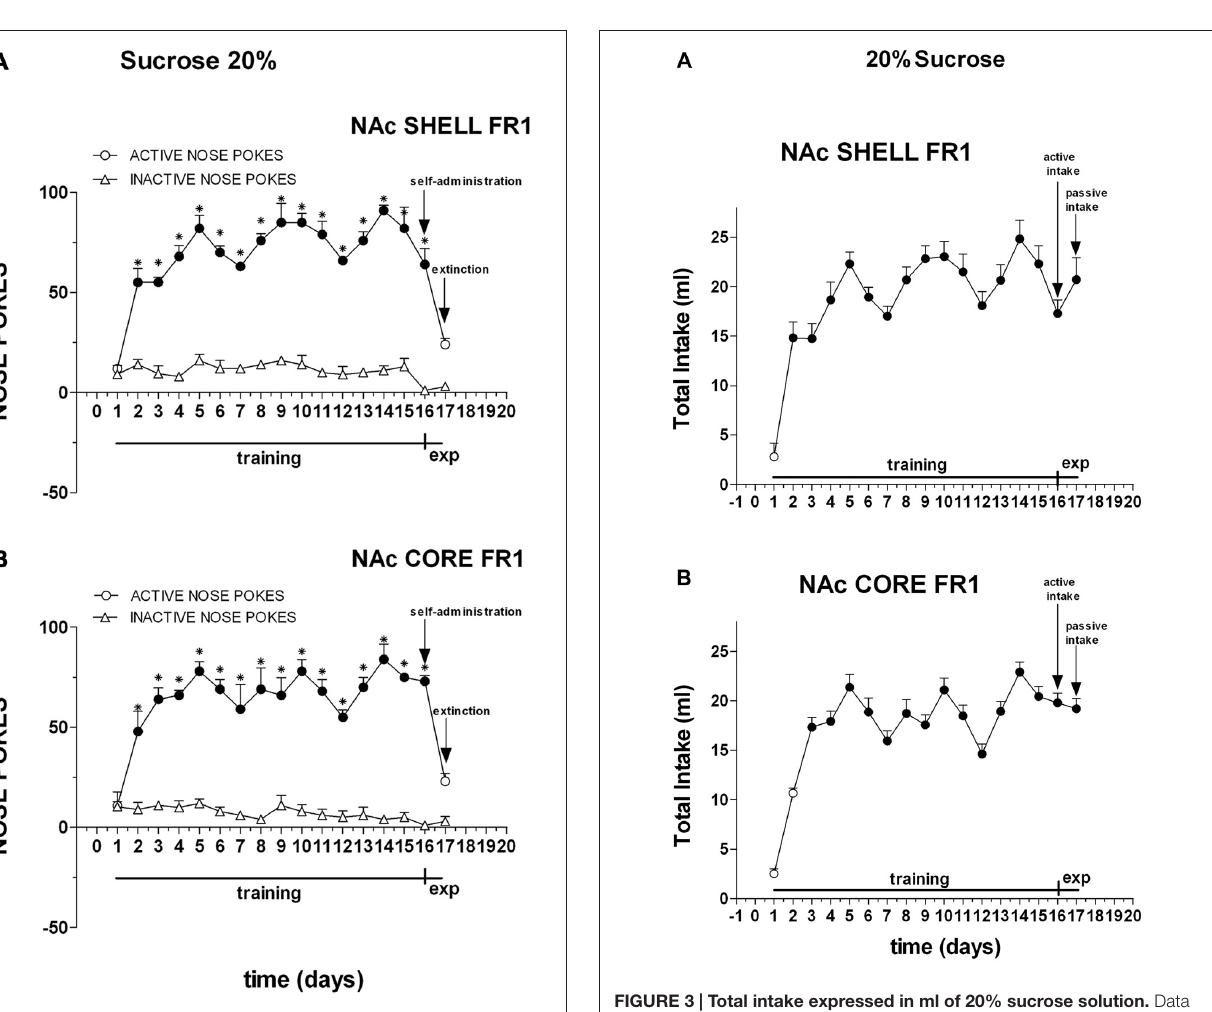
FIGURE 3 | Total intake expressed in ml of 20% sucrose solution. Data are means ± SEM of the results obtained in rats implanted with guide cannulas in the NAc shell (A) ( N = 4) and rats in the NAc core (B) ( N = 4). Filled symbols, p < 0.05 vs. 1st day. In contrast to responding for sucrose and to extinction, non-contingent sucrose presentation was associated with an increase of dialysate DA in both the NAc shell and core. Shell DA peaked at the first sample and had returned to basal values by the 5th sample; Core DA peaked at the 2nd sample and had returned to baseline by the 4th